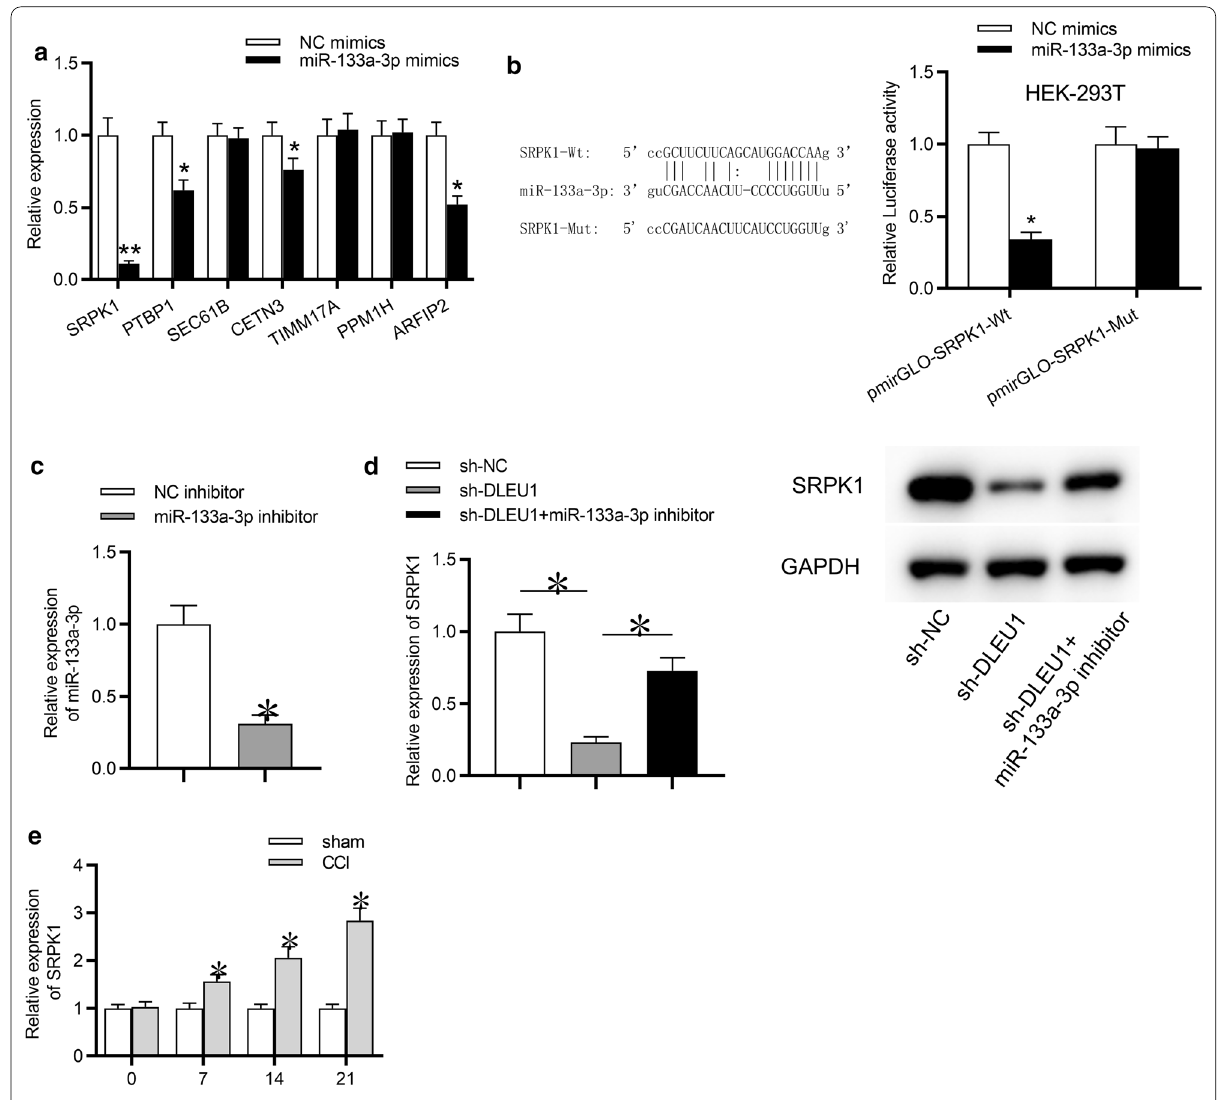
Fig. 4 SRPK1 was the downstream target of miR-133a-3p. a RT-qPCR analysis was conducted to detect the expression of target genes regulated by miR-216a-5p upregulation in rat microglial cells. b Luciferase reporter assay was conducted to explore the relationship between miR-133a-3p and SRPK1 in HEK-293T cells. c Expression of miR-133a-3p in rat microglial cells transfected with miR-133a-3p inhibitor or NC inhibitor was detected by RT-qPCR analysis. d RT-qPCR and western blot analyses were conducted to detect the mRNA or protein expression of SRPK1 in rat microglial cells by indicated transfections. e RT-qPCR analysis was conducted to assess the expression of SRPK1 in spinal cord tissues after CCI surgery for 0, 7, 14, 21 days. *p <